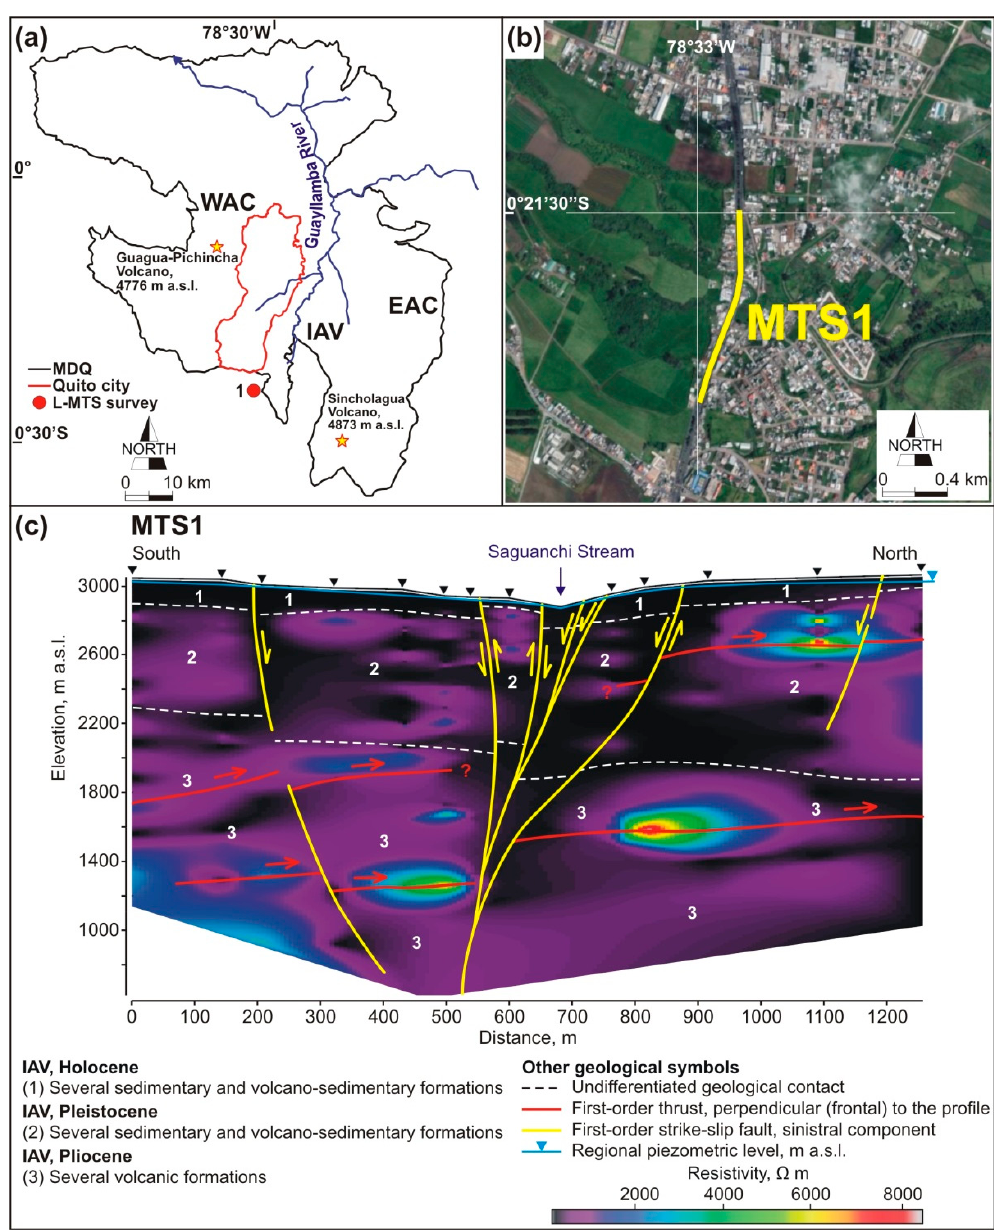
Figure 4. ( a ) General location of the selected low-frequency MTS survey labelled 1 in Figure 1b and Table 2, updated and reinterpreted from Peñafiel et al. [18]. ( b ) Detailed location of the selected low-frequency MTS profile, here called MTS1. ( c ) MTS1 profile. The regional piezometric level is singled out. Hydrogeological reinterpretation of the ER profile after [18] and regional [24,25] and local [26,33,34] hydrogeological information. Profile is topographically corrected, and the vertical-to-horizontal scale ratio is 0.34:1.